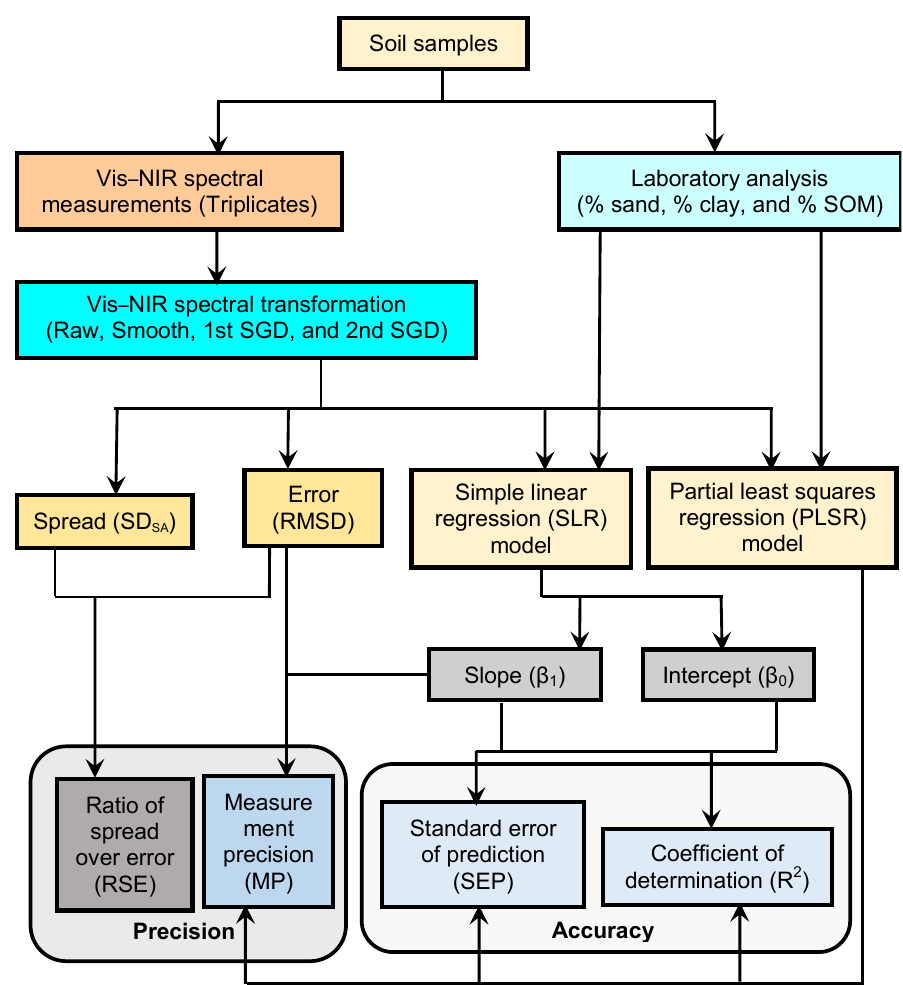
Figure 5. Illustration of the novel data processing methodology. All raw spectral data were processed using MATLAB 2012a (The MathWorks, Inc. Natick, MA, USA) and ParLeS 3.1 software (University of Sydney, Sydney, Australia), as described by [56]. All spectra exhibited a step discontinuity from 1023 to 1070 nm, caused by the transition from one detector to another. After removing the relatively noisy parts of the spectra at the edges of the detection ranges for each spectrophotometer (342–409 nm, 1014–1075 nm, and 2206–2220 nm), all resultant spectra consisted of a total of 363 measurements at different wavelengths. The spectral data were then corrected for offset and processed using a multiplicative scattering correction (MSC) algorithm [57] and mean centering (MC). In addition to these “raw” spectra, the following spectra treatments were pursued: (1) 3-point Savitzky–Golay smoothing, (2) 11-point first order Savitzky– Golay derivative (1st SGD), and (3) 11-point second order Savitzky–Golay derivative (2nd SGD)